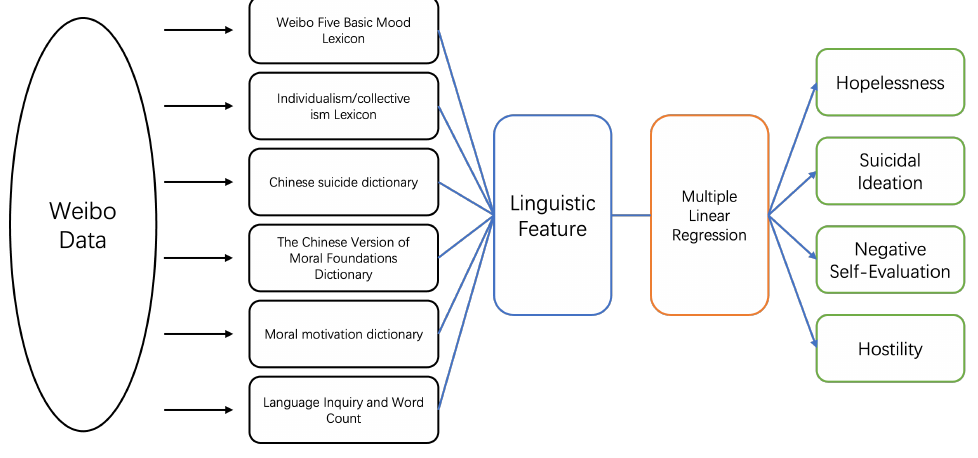
Figure 1. The Model